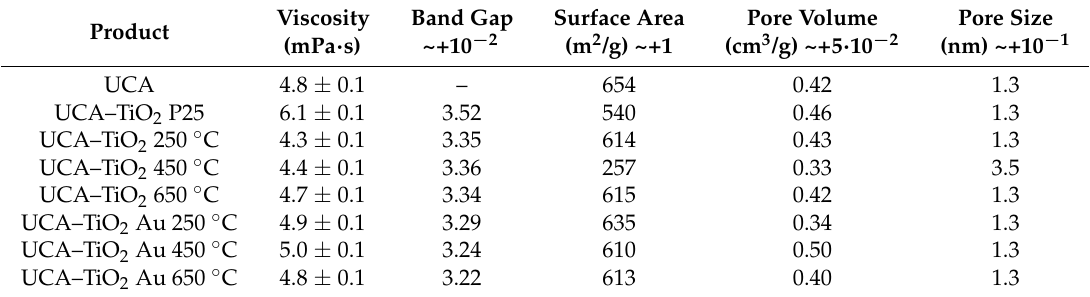
Table 1. Viscosity values of sols at 25 ◦ C and band gaps and textural for the mesoporous composites obtained from the